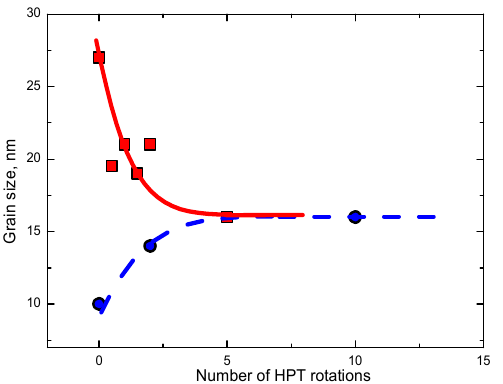
Figure 2. Grain size d after HPT plotted vs. number of rotations for pure coarse-grained steel sample (solid red squares) [60] and nanocrystalline steel produced by mechanical alloying (solid blue circles) [66].